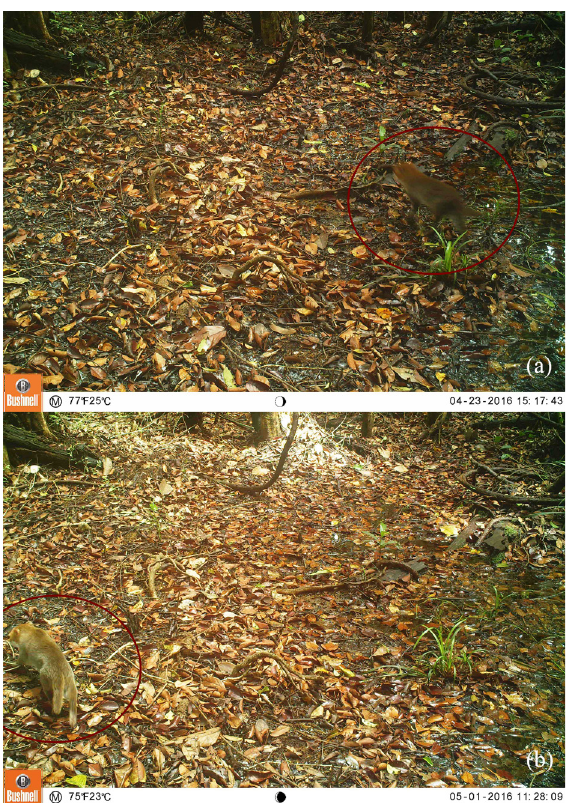
Table 1. Records of Flat-headed Cat in Ulu Sebuyau National Park (USNP), Maludam National Park (MNP), and Sarawak River (SR) in Sarawak, Malaysia from 2013 to 2018.